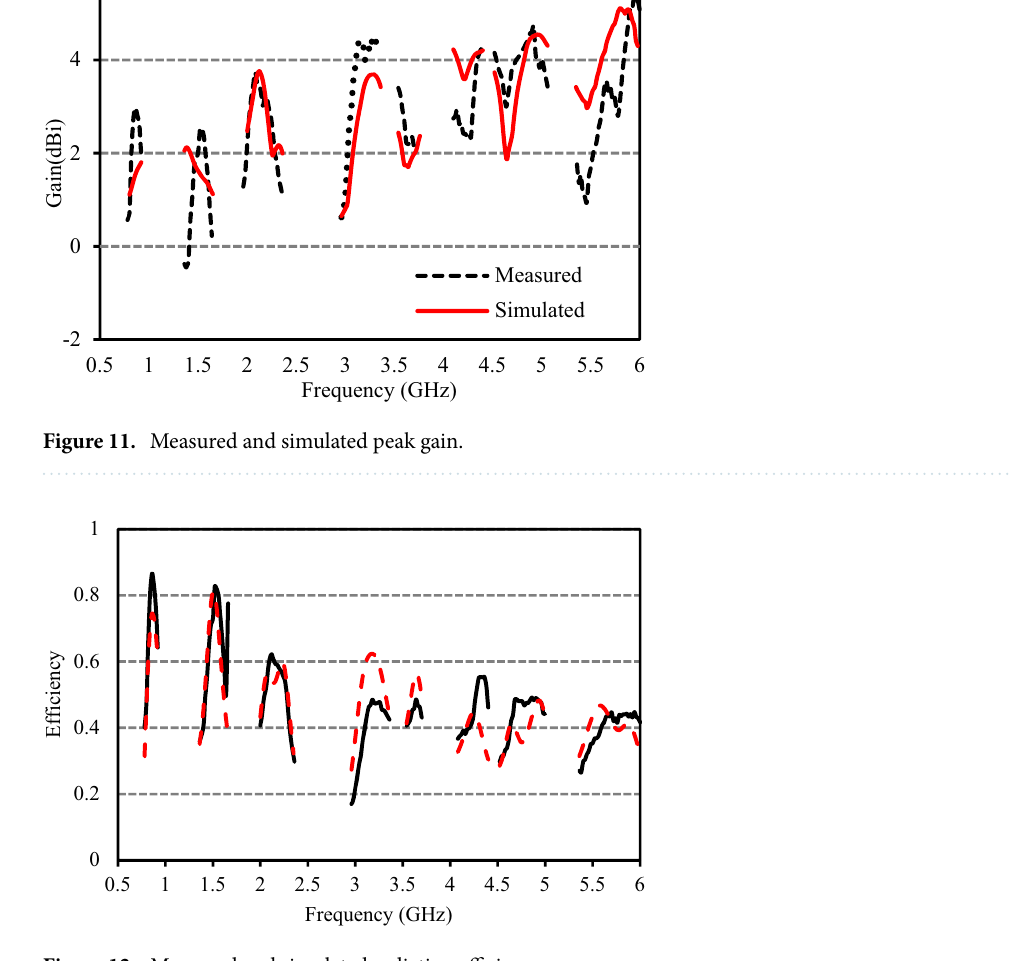
Figure 12. Measured and simulated radiation